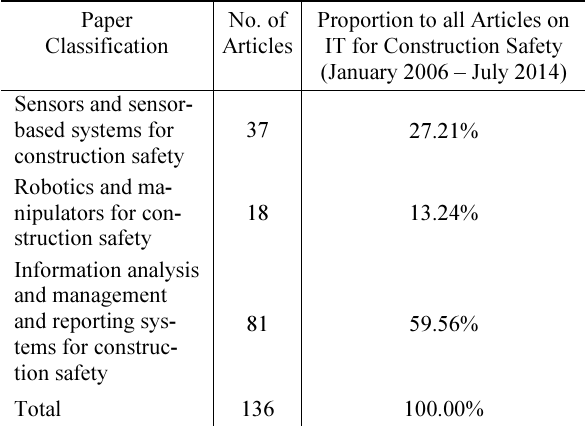
Table 1. Classification of articles on IT in construction safety